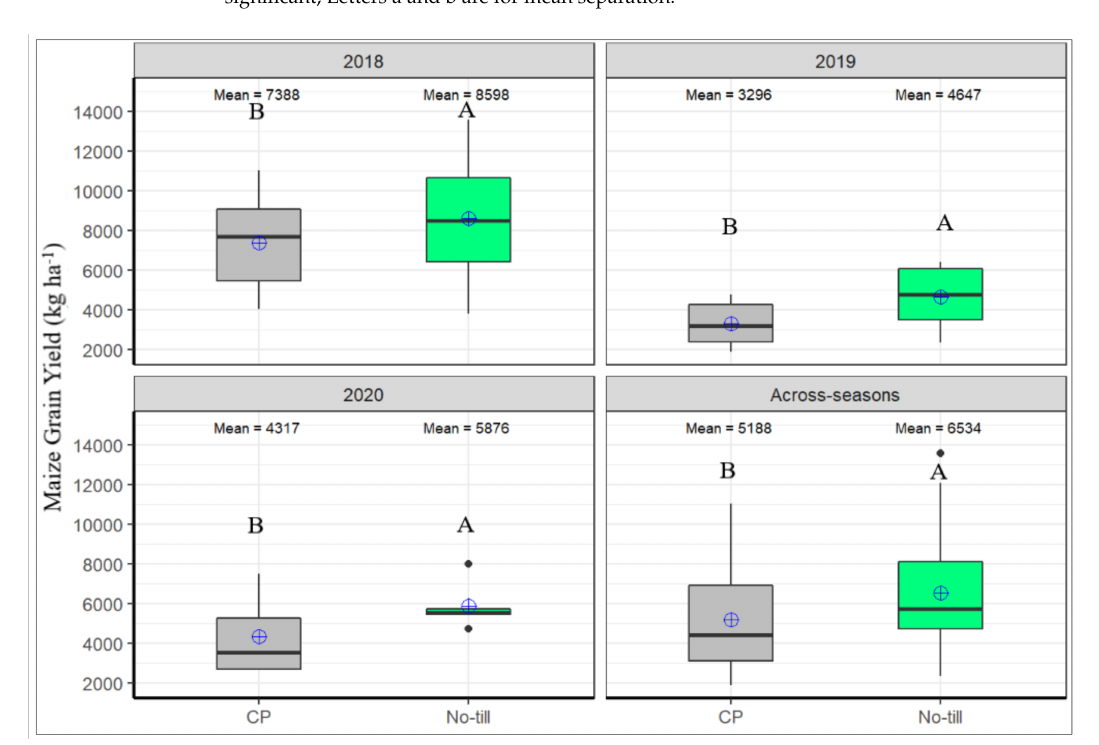
Figure 2. Maize grain yield from conventional practice and NT treatments in 2018, 2019, 2020 and across the growing seasons from experimental sites in the Gudeya-Billa district, Oromia, west- ern Ethiopia. Means with different letters (A, B) in the same season are significantly different at p < 0.05. The blue dots within each box represent the mean yield while the horizontal line represents the median